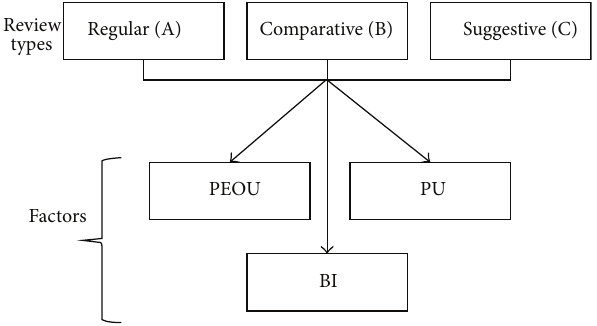
Figure 1: The proposed